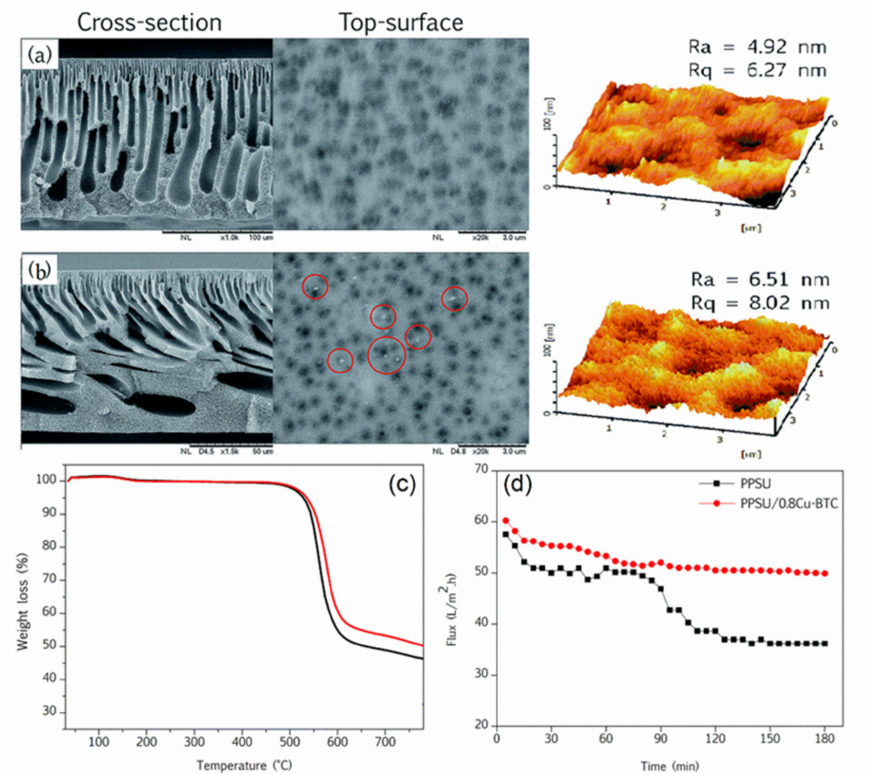
Figure 10. PPSU membranes embedded with Cu-BTC; SEM images of cross-section, top surface and 3D AFM images: ( a ) PPSU; ( b ) PPSU/Cu-BTC; ( c ) TGA curves; ( d ) flux profile